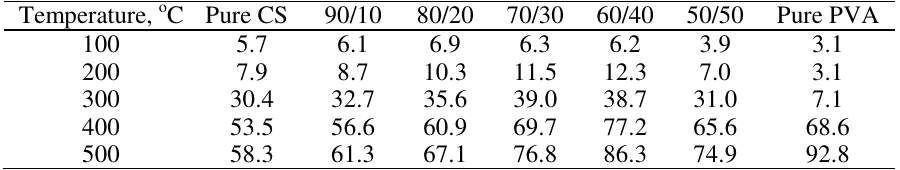
Table 2. The weight loss (%) of the pure components and their blends at different temperatures